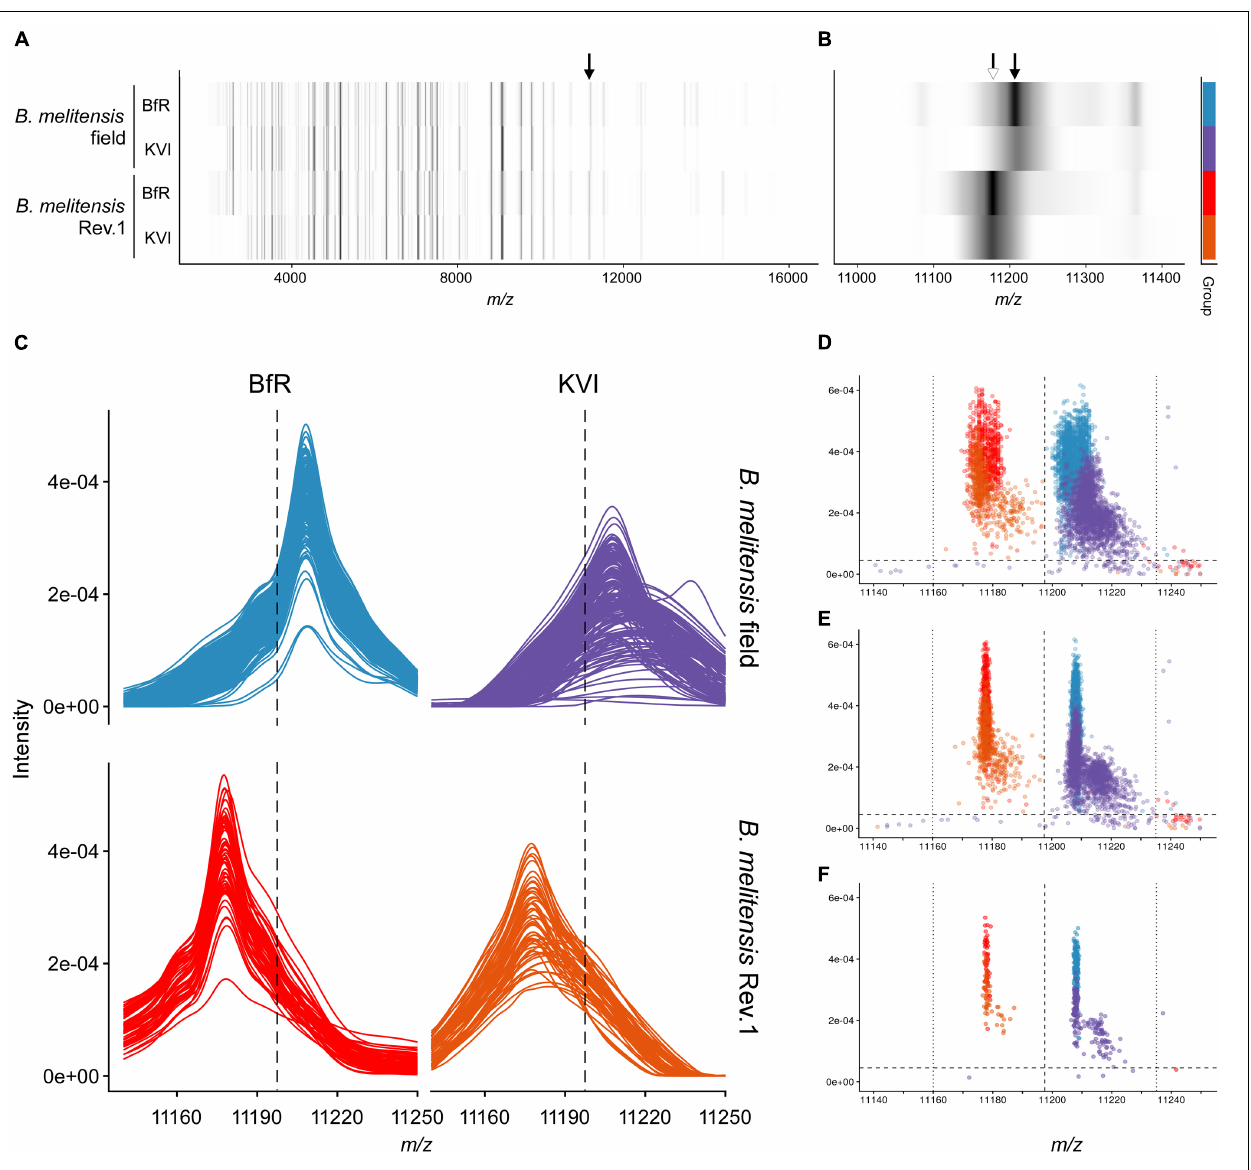
FIGURE 3 | Group spectra and peak discrimination for the single charged ribosomal protein L24. (A,B) Gel view of group spectra derived from the B. melitensis field isolate group “ melitensis ” and the vaccine strain group “ melitensis Rev.1” presented by institute “BfR” and “KVI,” in the full acquisition window (A) and magnified to the m/z range enclosing the exact masses of PLF_234_00001168, z = 1 (B) . Arrows point to accurate masses at 11,178 Da [white, (M Thr 28 +H) + ion] and 11,208 Da [black; (M Met28 +H) + ion]. (C) Line graphs of aligned sample spectra shown by group and institute. (D–F) Scatterplot of peaks in the technical replicate spectra before (D) and after alignment (E) against the reference spectrum. (F) Peaks derived from aligned sample spectra. Intensity cut-off (horizontal dashed line) in panels (C–F) : 0.000045 AU; for mass cut-offs (decision window: vertical dotted lines, decision boundary: vertical dashed line) see Table 2